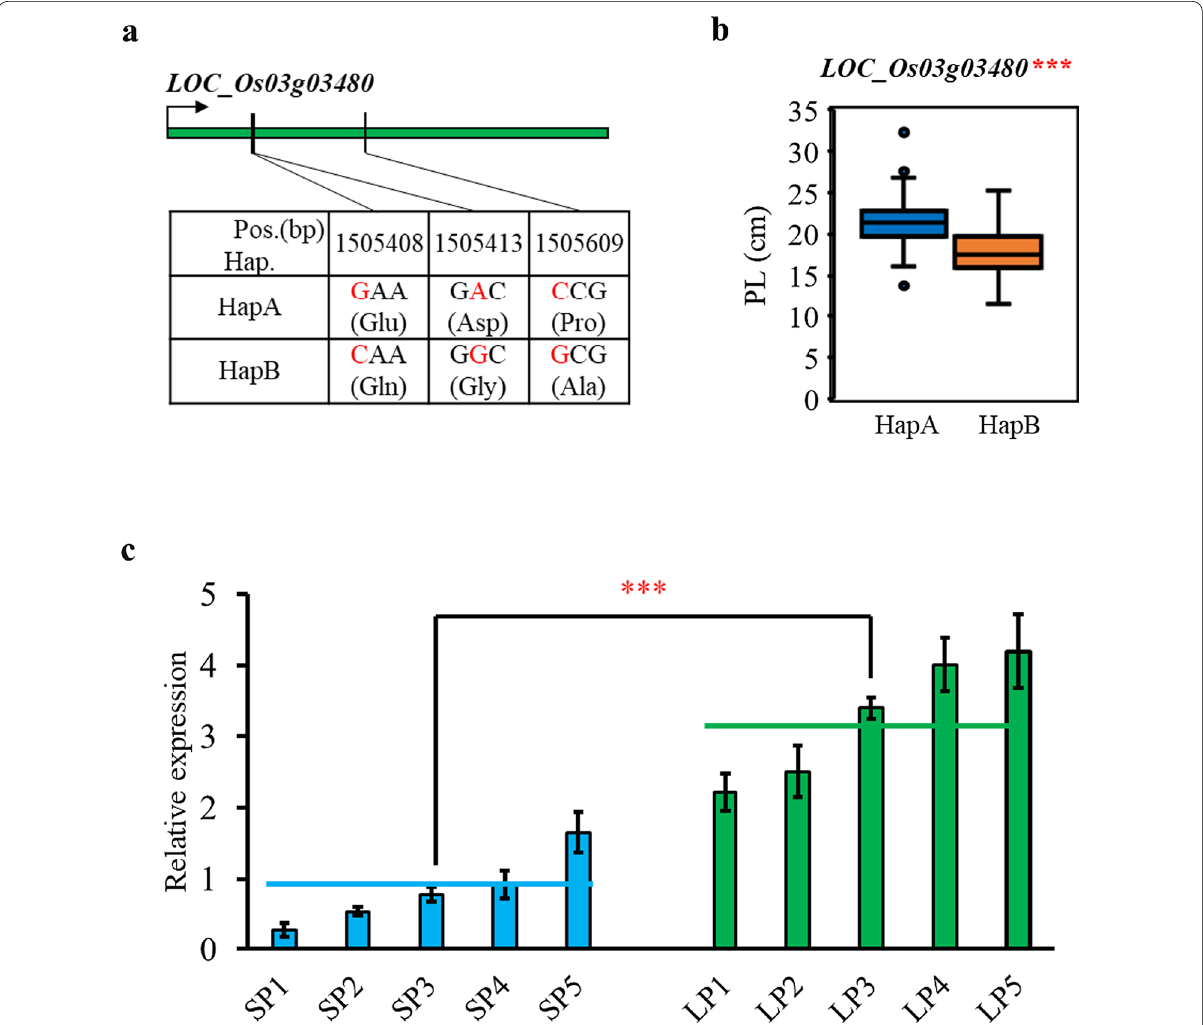
Fig. 5 Two candidate genes analysis in qPL3-3. a Schematic representation of LOC_Os03g03480 structure and the position of 3 non-synonymous SNP used for haplotype analysis. b Box plots for panicle length (PL) in the two haplotypes of LOC_Os03g03480 in 2017. Boxes show median, and upper and lower quartiles. Whiskers extend to 1.5 the interquartile range, with any remaining points indicated with dots. *** P < 0.001 (Welch two × sample t -test). c Relative expression of DSM2 in short panicle (SP) and long panicle (LP) accessions. The blue and green horizontal lines depict the average expression levels in the SP and LP accessions, respectively. *** P < 0.001 (Welch two sample t -test). SP1: IRIS_313-8085; SP2: IRIS_313-8096; SP3: IRIS_313-8099; SP4: IRIS_313-8195; SP5: IRIS_313-8048; LP1: IRIS_313-8903; LP2: B199; LP3: IRIS_313-9505; LP4: IRIS_313-7993; LP5: